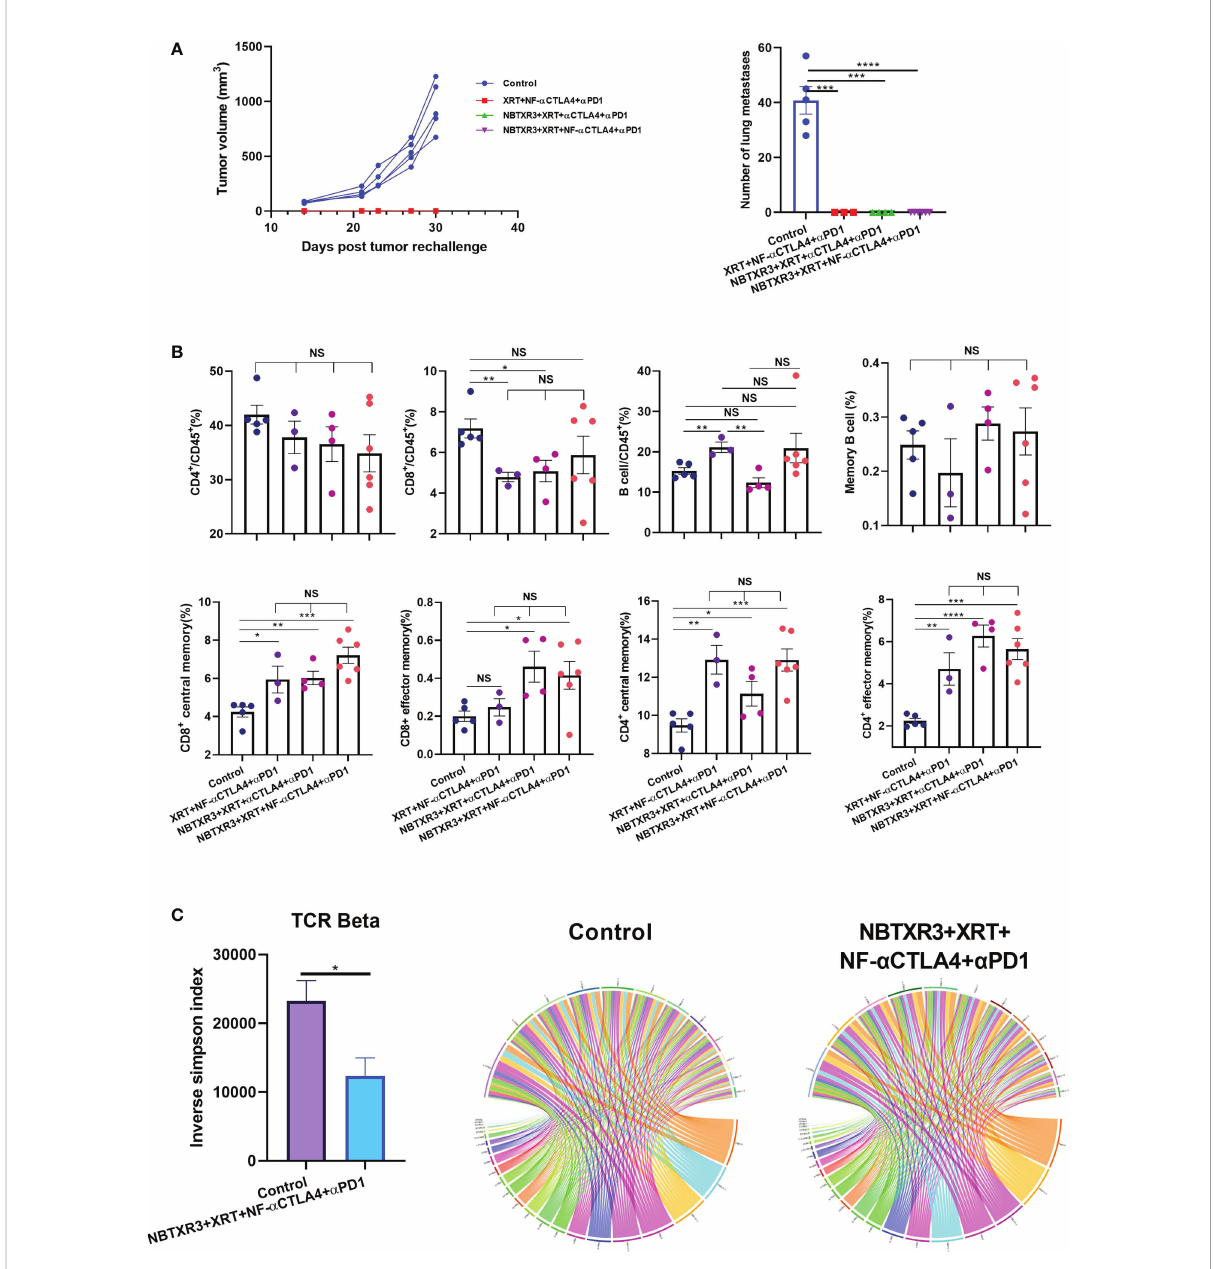
FIGURE 5 Immunoradiotherapies generate long-term antitumor memory immune response. (A) Tumor growth curves and the number of lung metastases of survivors after tumor rechallenge. (B) Memory immune cells populations in survivor mice. (C) Inverse Simpson index of TCR b and representative circos plots displaying the pairings of V-J gene families of the TCR b in survivor mice and control mice. The survivor mice cured by different immunoradiotherapies were rechallenged with 344SQR cells 156 days following their fi nal fraction of radiation. Tumor growth was monitored, and the memory immune cells populations were pro fi led 21 days post tumor rechallenge. Data are expressed as means± standard error of the mean (SEM). P<0.05 was considered statistically signi fi cant. *P<0.05, **P<0.01, ***P<0.001, ****P<0.0001, NS, not signi fi